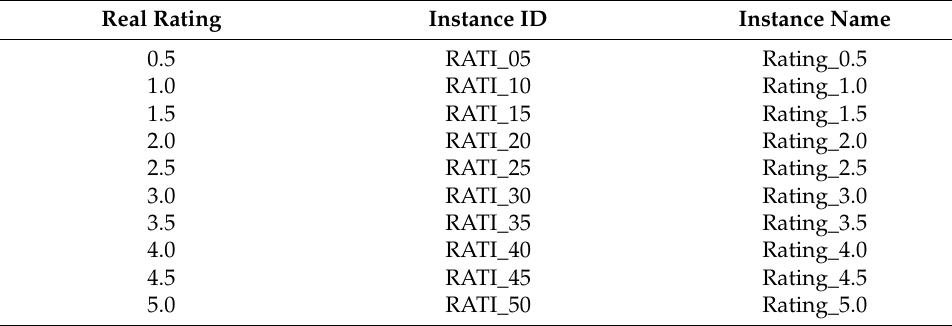
Table A3. Categorization criteria of “Rating” class in the